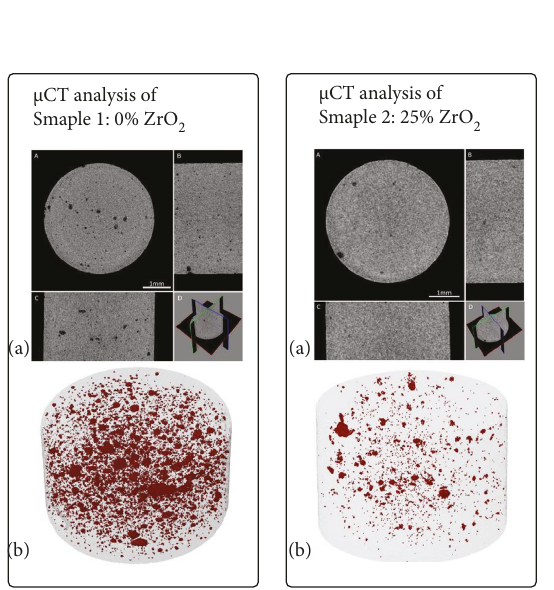
Figure 3: Analysis of the µ CT of the set cement: (a) Three per- pendicular sections: traverse A longitudinal B and sagittal C along with their spatial visualisation D (b) Visualisation of sample pores in a two-dimensional